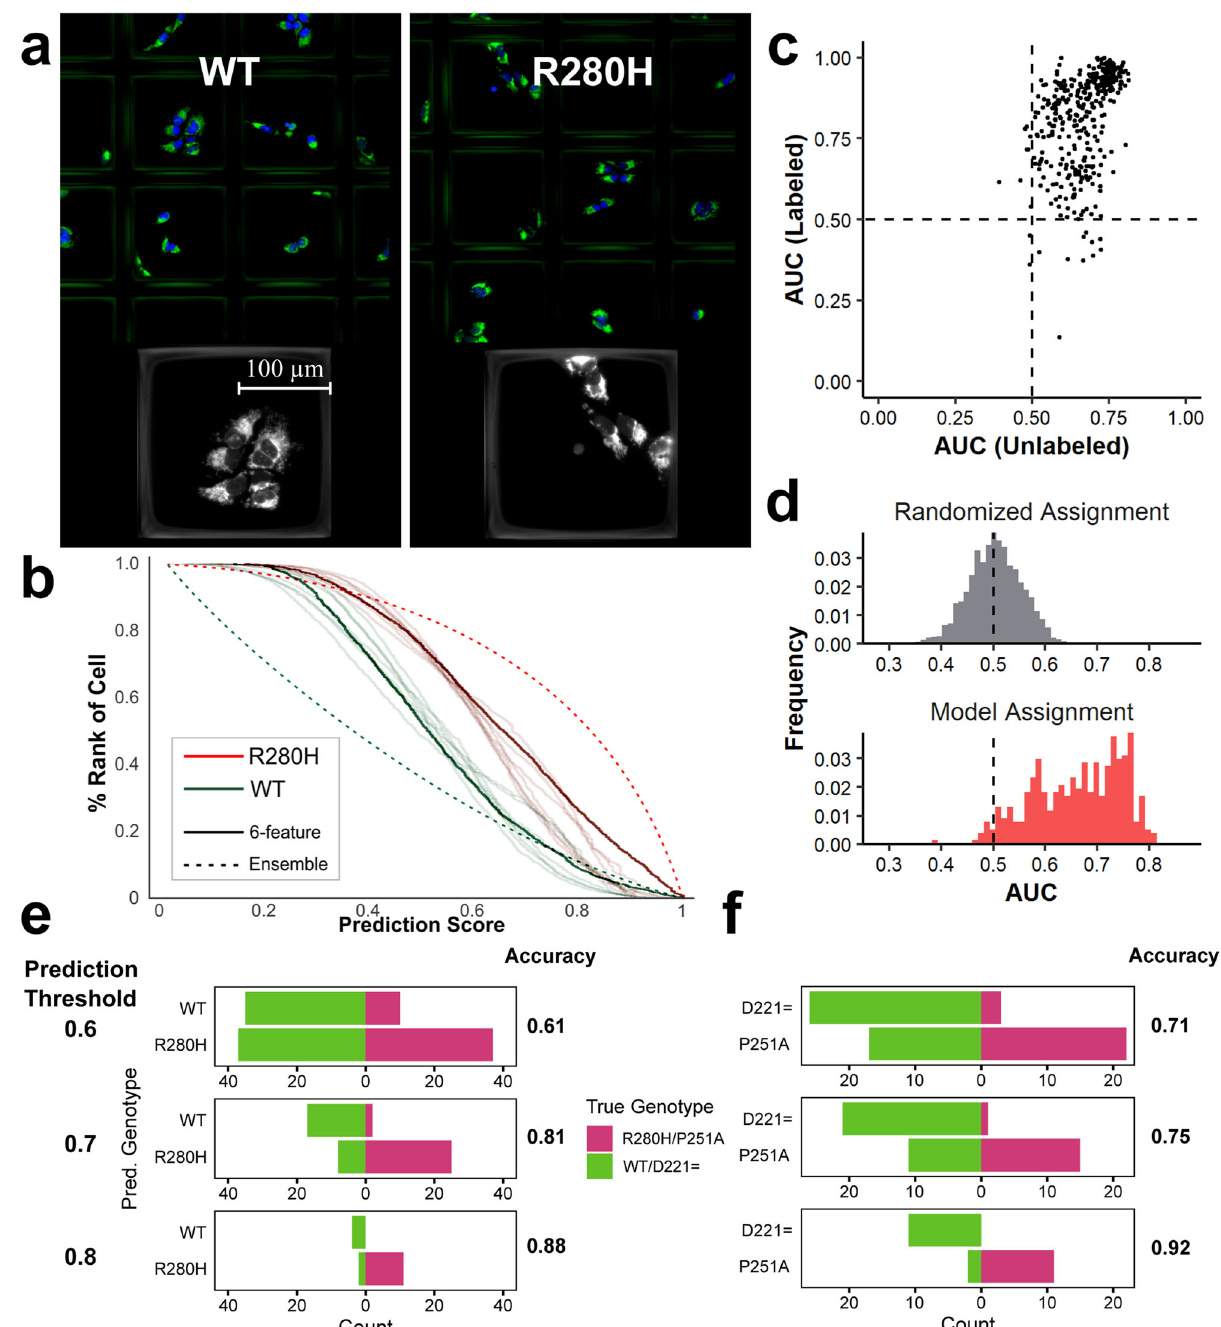
Fig. 4 Raft-seq can predict MFN2 WT and MFN2 R280H mutant cells which have nearly undetectable phenotypic differences. a Images of the R280H mutant and MFN2 WT cell line in the microraft plate. b Ranked histogram of the prediction scores for several models predicting the genotype from the R280H experiment. Each curve shows the distribution of prediction scores for a particular labeled genotype (WT or R280H) where a score of 0 means the model is con fi dent that a particular cell is WT and a score of 1 means the model has a strong prediction of R280H. 8 different 6-feature models are shown. The dashed lines indicate an ensemble model. c Scatterplot showing the performance of all 433 models in detecting mutants in a mixture of wild-type cells and the R280H mutant. d A histogram of AUCs for models detecting mutants in a mixture of wild-type cells and the R280H mutant. A histogram of AUCs generated from randomly assigned models for comparison. e , f Accuracies and confusion bar charts of the predictions from the unlabeled wells, when only picking cells with prediction scores ≥ 0.9 ( ≤ 0.1), ≥ 0.8 ( ≤ 0.2), and ≥ 0.7 ( ≤ 0.3). e uses the model to predict R280H against WT MFN2 , while f uses the model to predict P251A against D221 =